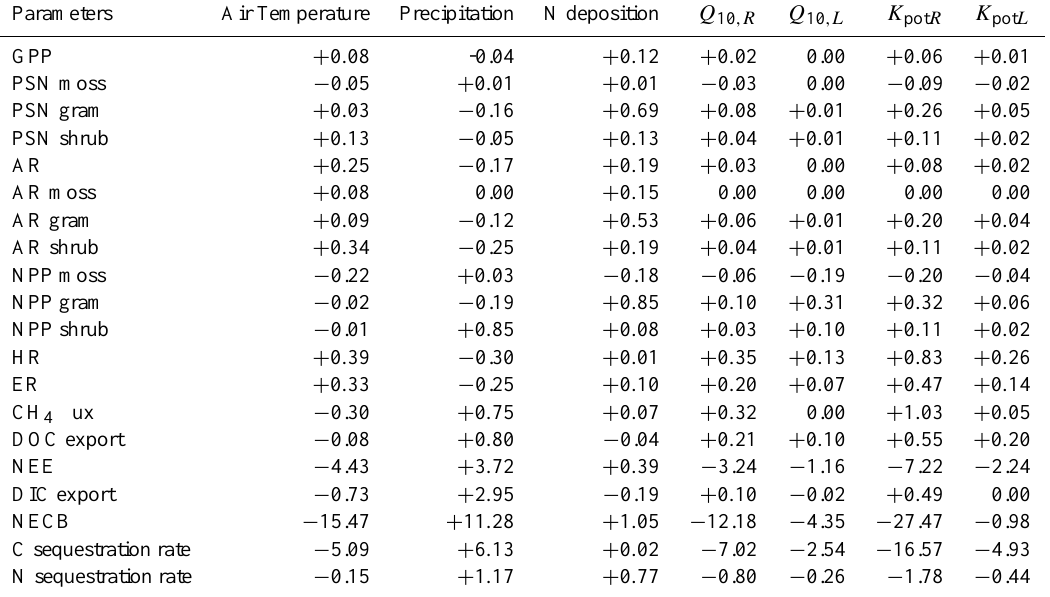
Table 5. Results of sensitivity analyses. The values shown are the average relative changes in model output per change of parameter (Jørgensen and Bendoricchio, 2001). Annual C fluxes (unit: gCm − 2 yr − 1 ) averaged over 6yr from 1999 to 2004 were compared per change of air temperature (unit: ◦ C), precipitation (unit: mday − 1 ) , N deposition level (gNm − 2 yr − 1 ) , Q 10 (no unit) and kpot (potential decompo- sition constant, unit: day − 1 ) of the labile and recalcitrant Peat. ( + ) indicates a positive relation between the change in the parameter and the change C and N pools or fluxes. (-) indicates an inverse relation between the change in parameter and the change in C and N pools or fluxes. Parameters Air